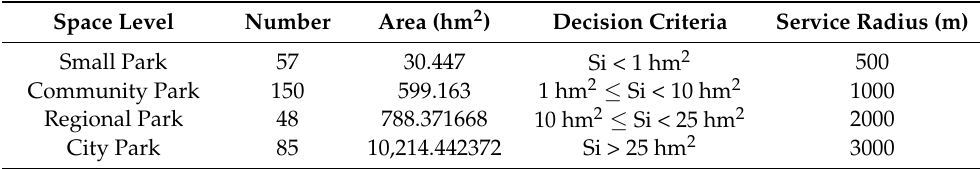
Table 1. Statistics on the classification of UPGS.